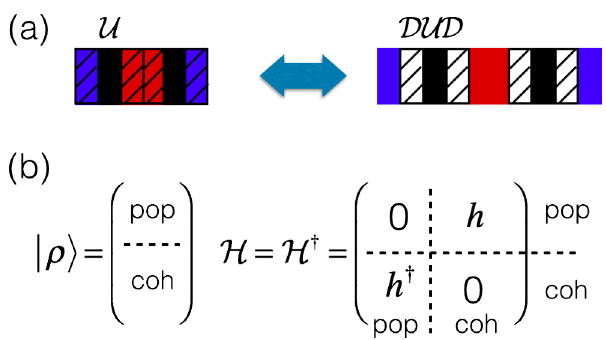
FIG. 8. Panel (a), left side: Dephasing operations (slanted line, operator D ) commute with thermal baths so the dephased engine in the left side of (a) is equivalent to the one on the right. In the new engine, the unitary evolution is replace by DUD . If D eliminates all coherences, the effect of DUD on the populations can always be written as a doubly stochastic operator. (b) Any Hermitian Hamiltonian in Liouville space has the structure shown in (b). Thus, first-order changes in populations critically depend on the existence of